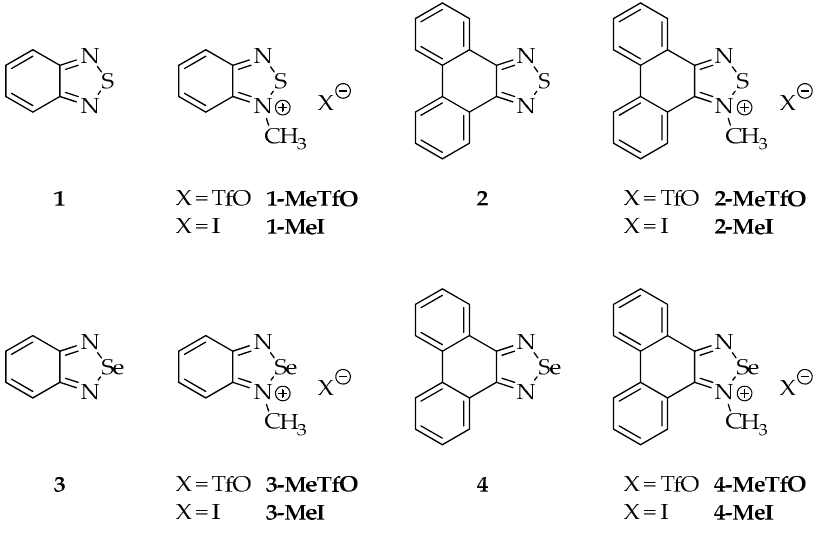
Figure 3. Structures of all studied compounds.